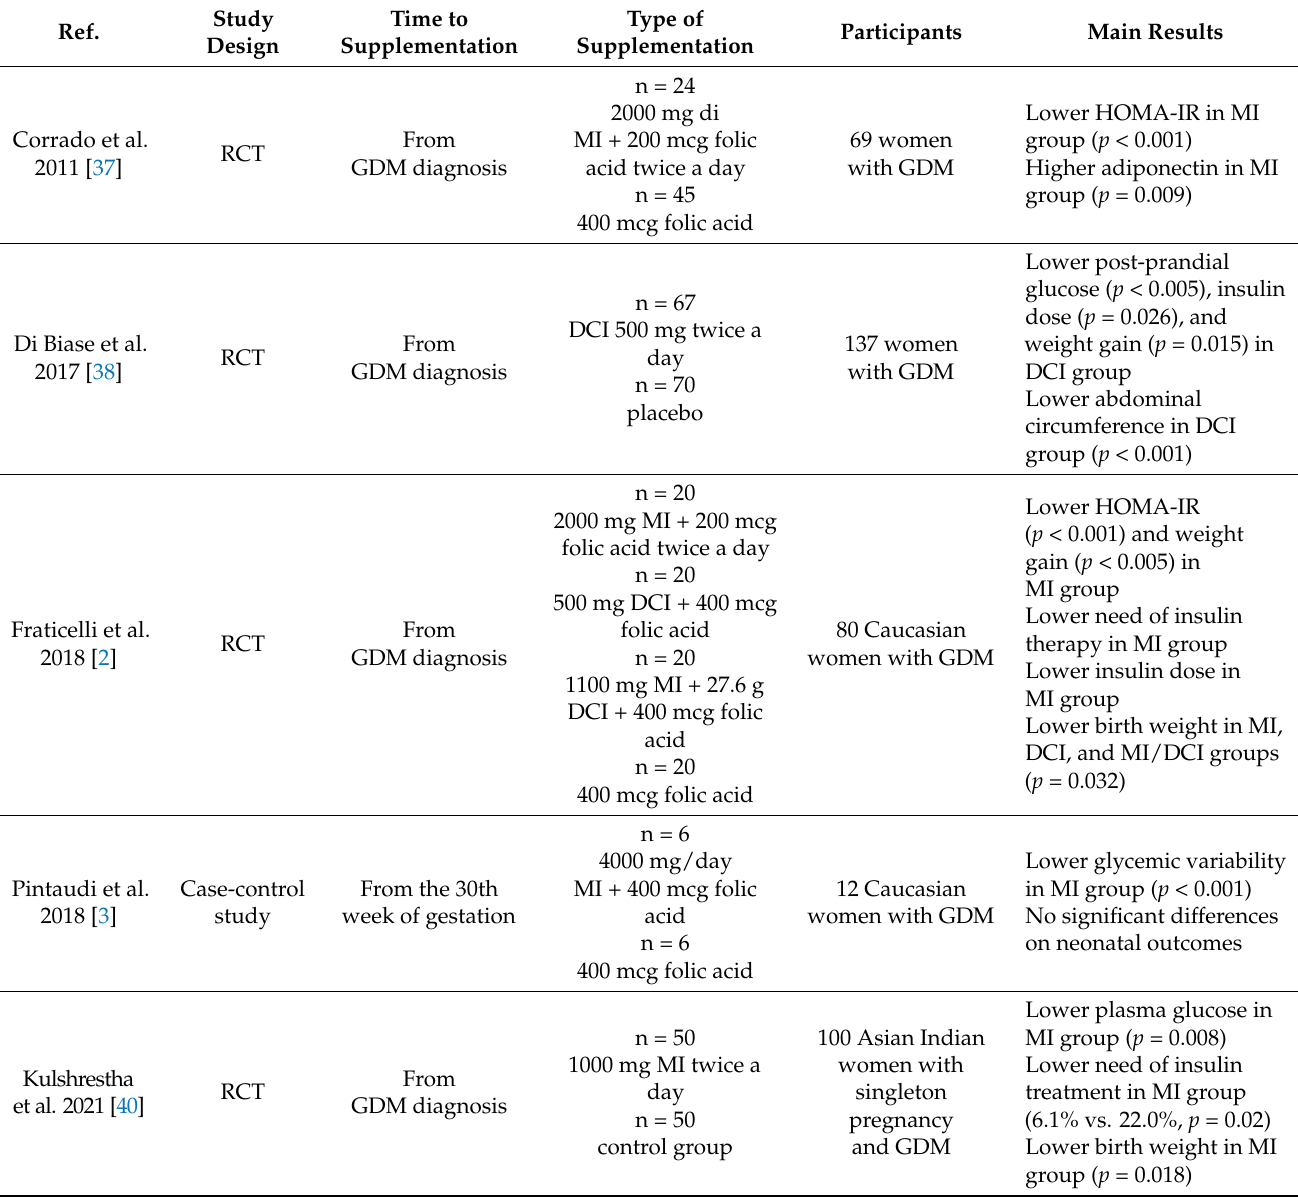
Table 2. Studies on inositol supplementation to treat gestational